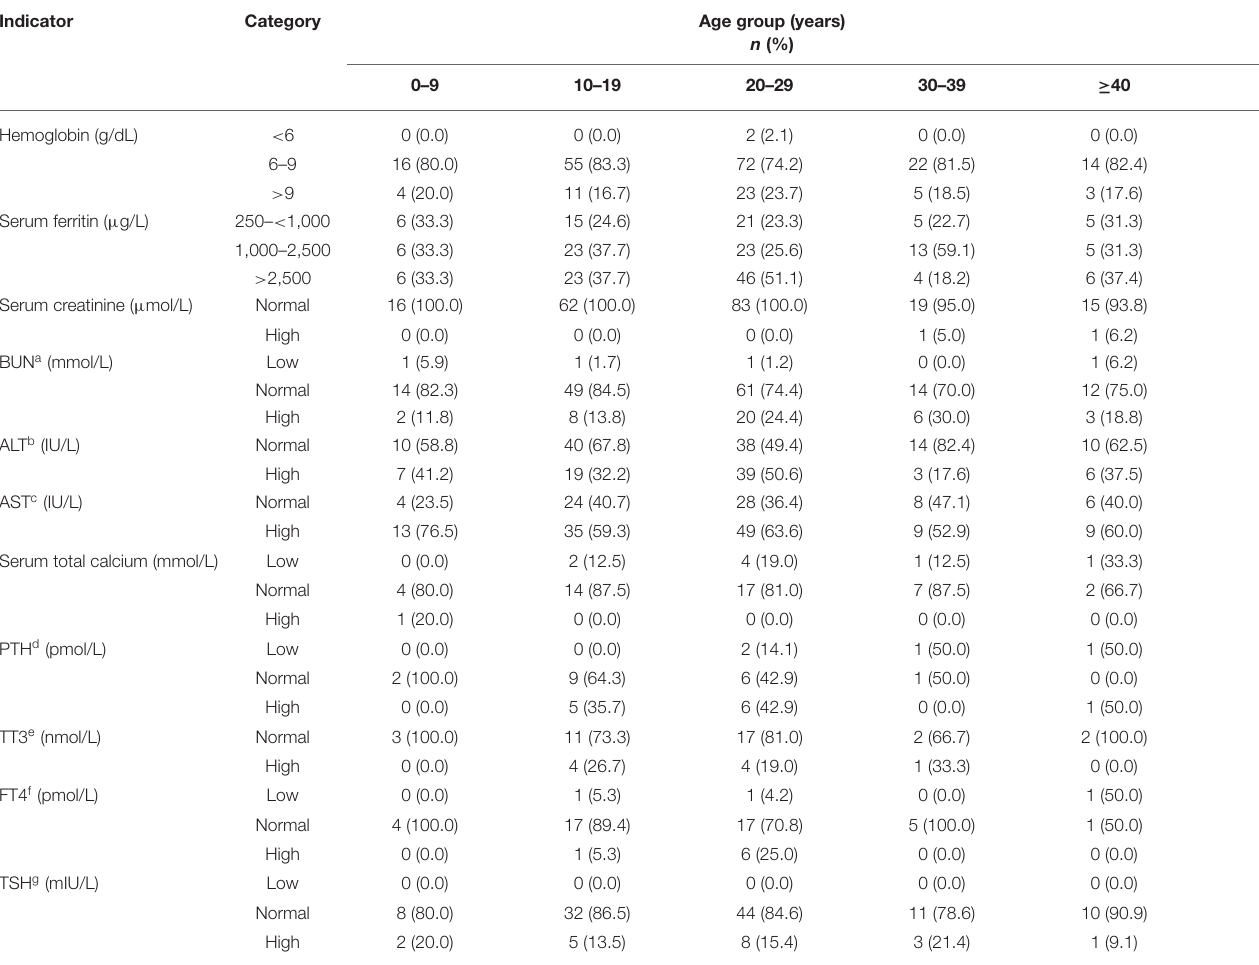
TABLE 3 | The biochemical, hematological, and hormonal baseline characteristics of patients with β -thalassemia by age. Indicator